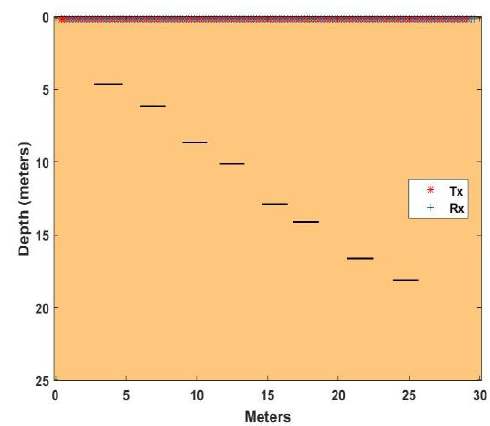
Figure 12. Defined space SA2, with (8) 2-m-long plates, 0.1 m thick at nearly 5, 6, 9, 10, 13, 14, 17, and 18 m with Tx/Rx pair 0.15 m above the ground [2 – 4].